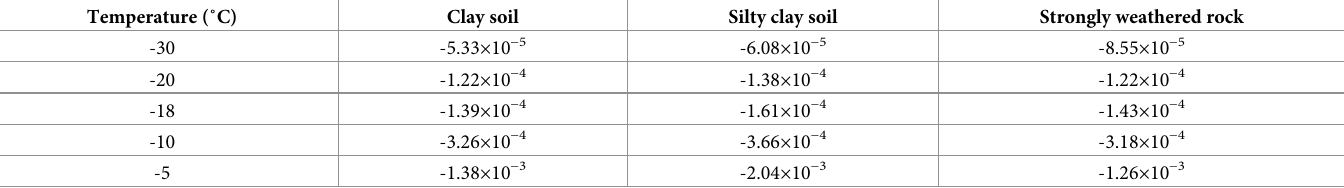
Table 5. Expansion coefficients of layers of strongly weathered rock, silty clay soil, and clay soil.